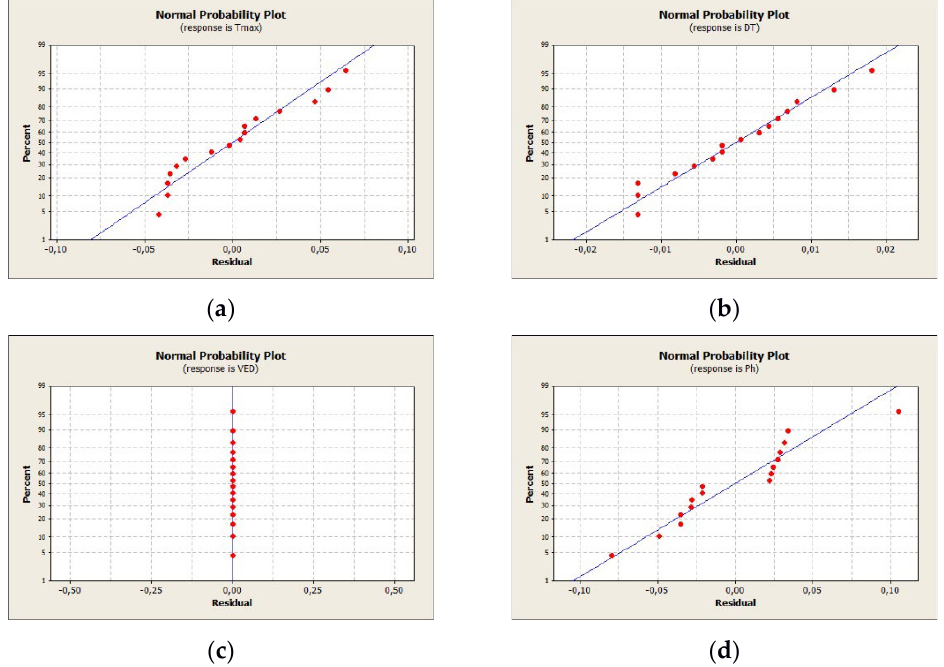
Figure 12. Residual normal plots for the output variables of ( a ) T max , ( b ) Δ T , ( c ) VED , and ( d ) P h